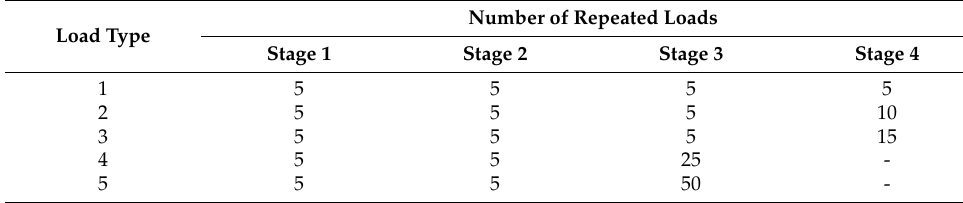
Table 9. Repeated loading types for test specimens.